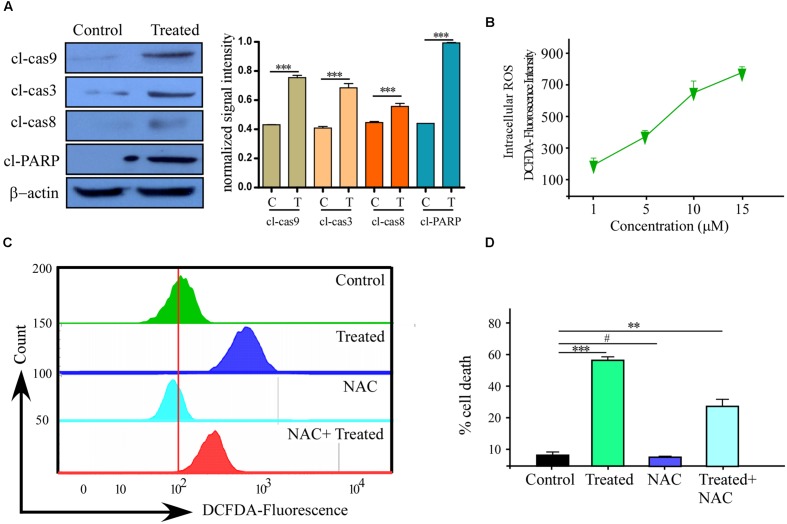
Reactive oxygen species (ROS) production with Caspase activation is one of the reason of Phemindole mediated MDAMB-231 cells apoptosis.
(A) Western blot analysis of cleaved caspase-3, cleaved caspase-9, cleaved caspase-8 and cleaved-PARP in control and Phemindole treated MDAMB-231 cells (Left panel). β-actin was used as loading control. Blots are representative of three independent experiments and quantifications are indicated by Bar diagram (Right panel). Values were normalized by intensity of positive control. (B) Line diagram representation of the dose dependent ROS production in MDAMB-231 cells on treatment with Phemindole. (C) Phemindole treated MDAMB-231 cells were assessed by flow cytometry for ROS generation by measuring the DCF-fluorescence intensity and the data was represented by histogram overlay. (D) Percentage of cell death from Phemindole induced with/without NAC (a pharmacological inhibitor of ROS) was assessed and represented in bar diagram. As described in methods the statistic data were presented as mean ± SE from three independent experiments. ∗,∗∗,∗∗∗,# indicate p < 0.05, p < 0.01, p < 0.0005, p < 0.05 respectively versus untreated or control group.